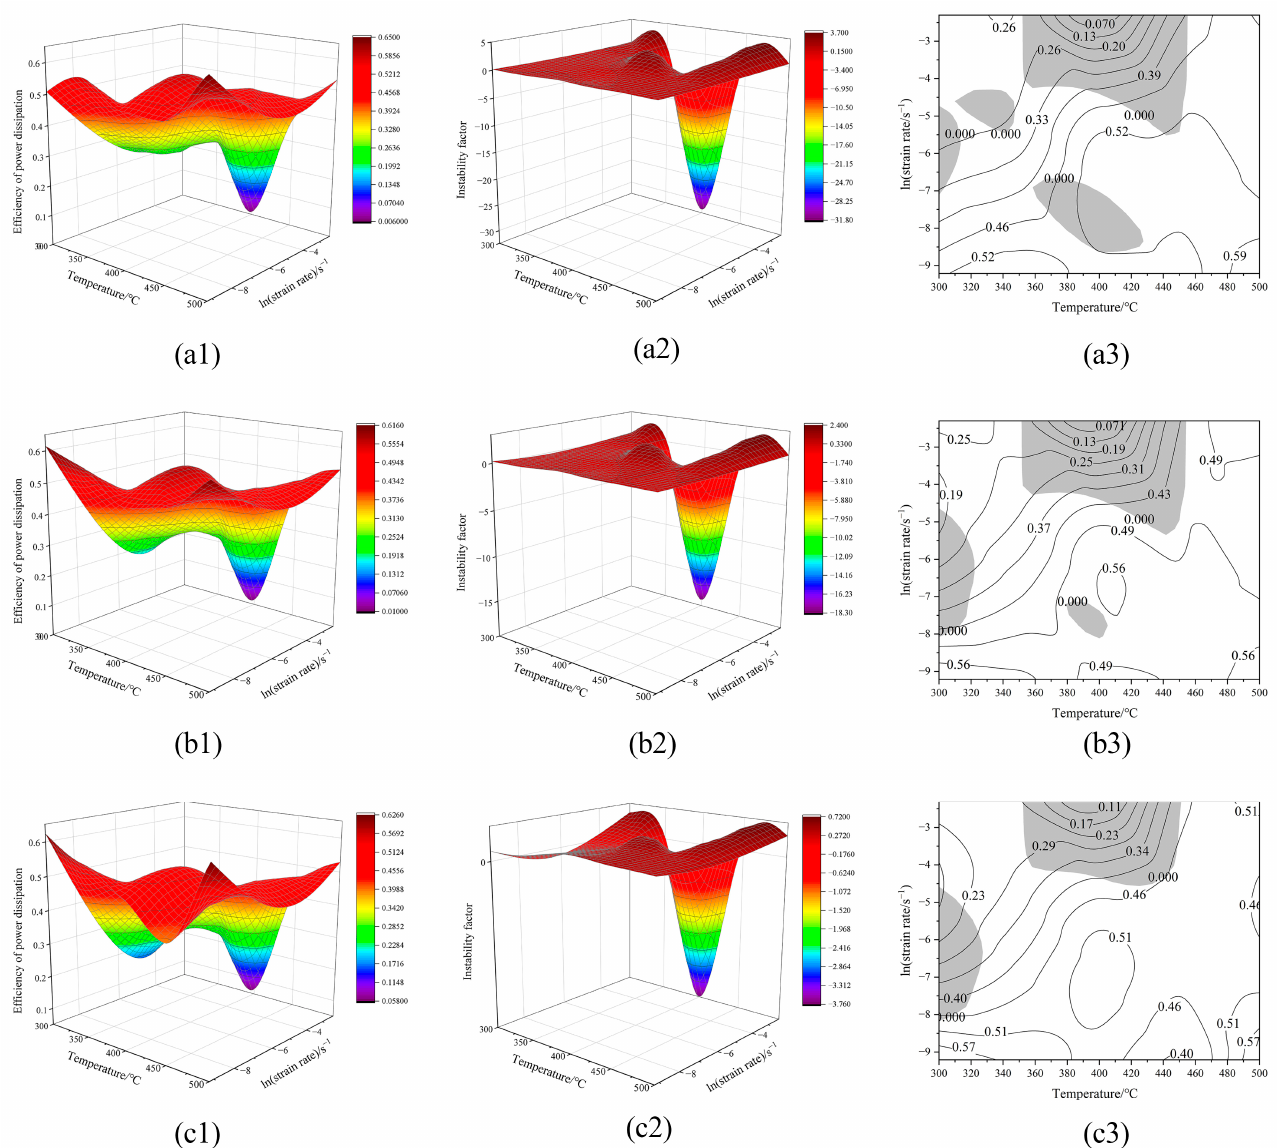
Figure 7. Power dissipation maps for different strains: ( a1 ) ε = 0.1; ( b1 ) ε = 0.2; ( c1 ) ε = 0.3. Instability maps at different strains: ( a2 ) ε = 0.1; ( b2 ) ε = 0.2; ( c2 ) ε = 0.3. Hot processing maps at different strains: ( a3 ) ε = 0.1; ( b3 ) ε = 0.2; ( c3 ) ε = 0.3.